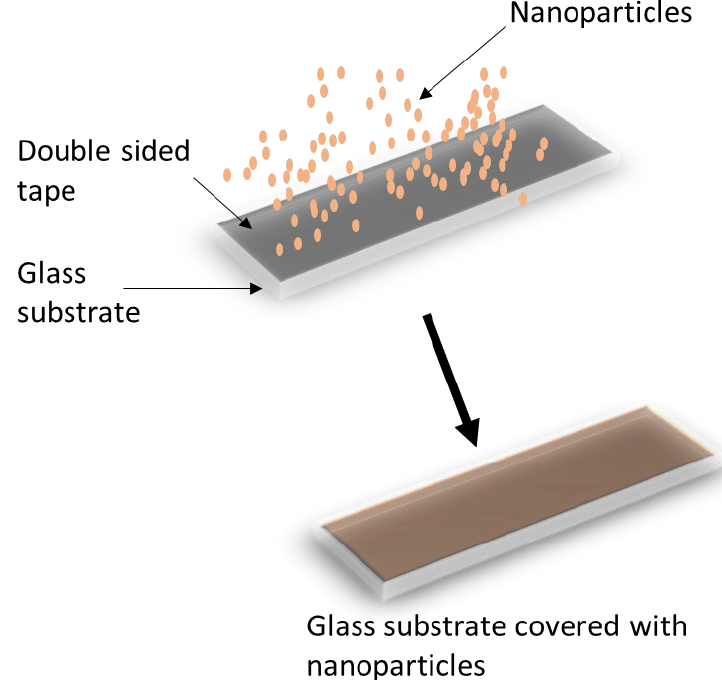
Figure 1. A schematic diagram of the prepared films used in this study.